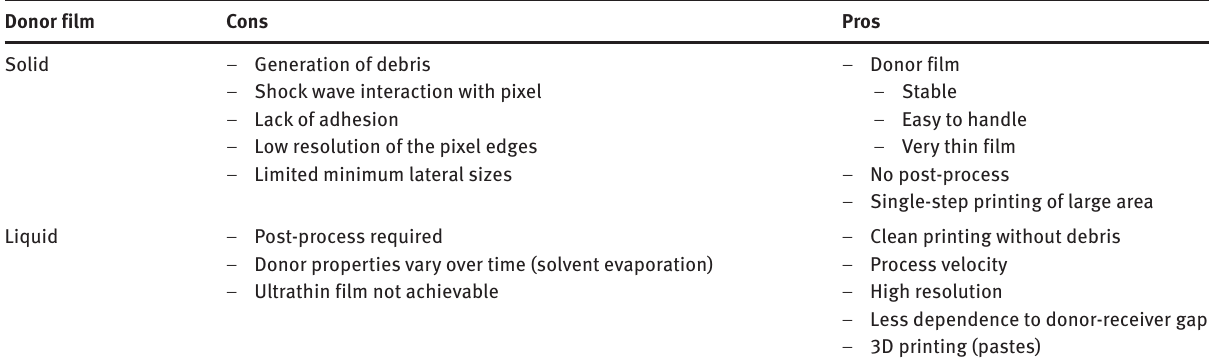
Table 1: Pros and cons of the LIFT processes from solid and liquid donor film. Donor film Cons Pros Solid